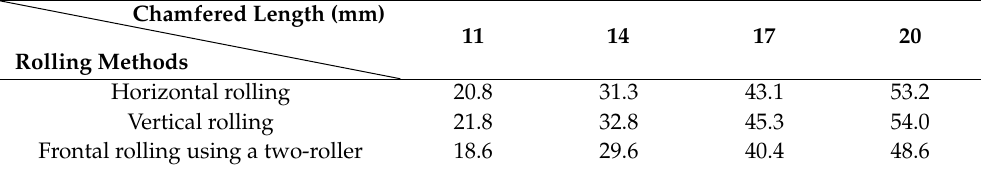
Table 1. Required rolling force for different rolling methods.